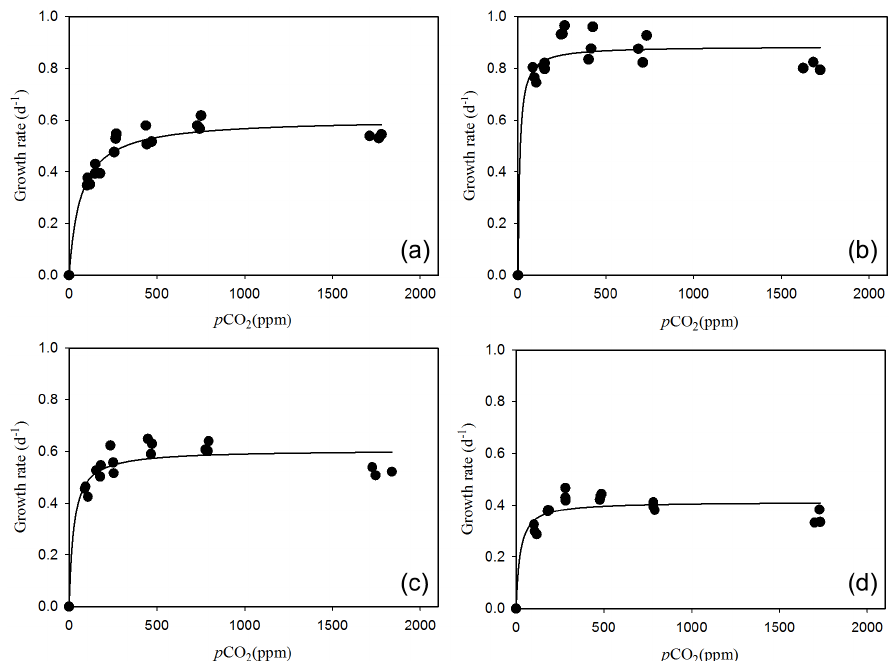
Figure 5. CO 2 functional response curves showing specific growth rates (and fitted curves) across a range of CO 2 concentrations from ∼ 100 to ∼ 1730ppm at 2 and at 8 ◦ C. Pseudo-nitzschia subcurvata at 2 ◦ C (a) and 8 ◦ C (b) and Phaeocystis antarctica at 2 (c) and 8 ◦ C (d) . Values represent the means and error bars represents the standard deviations of triplicate